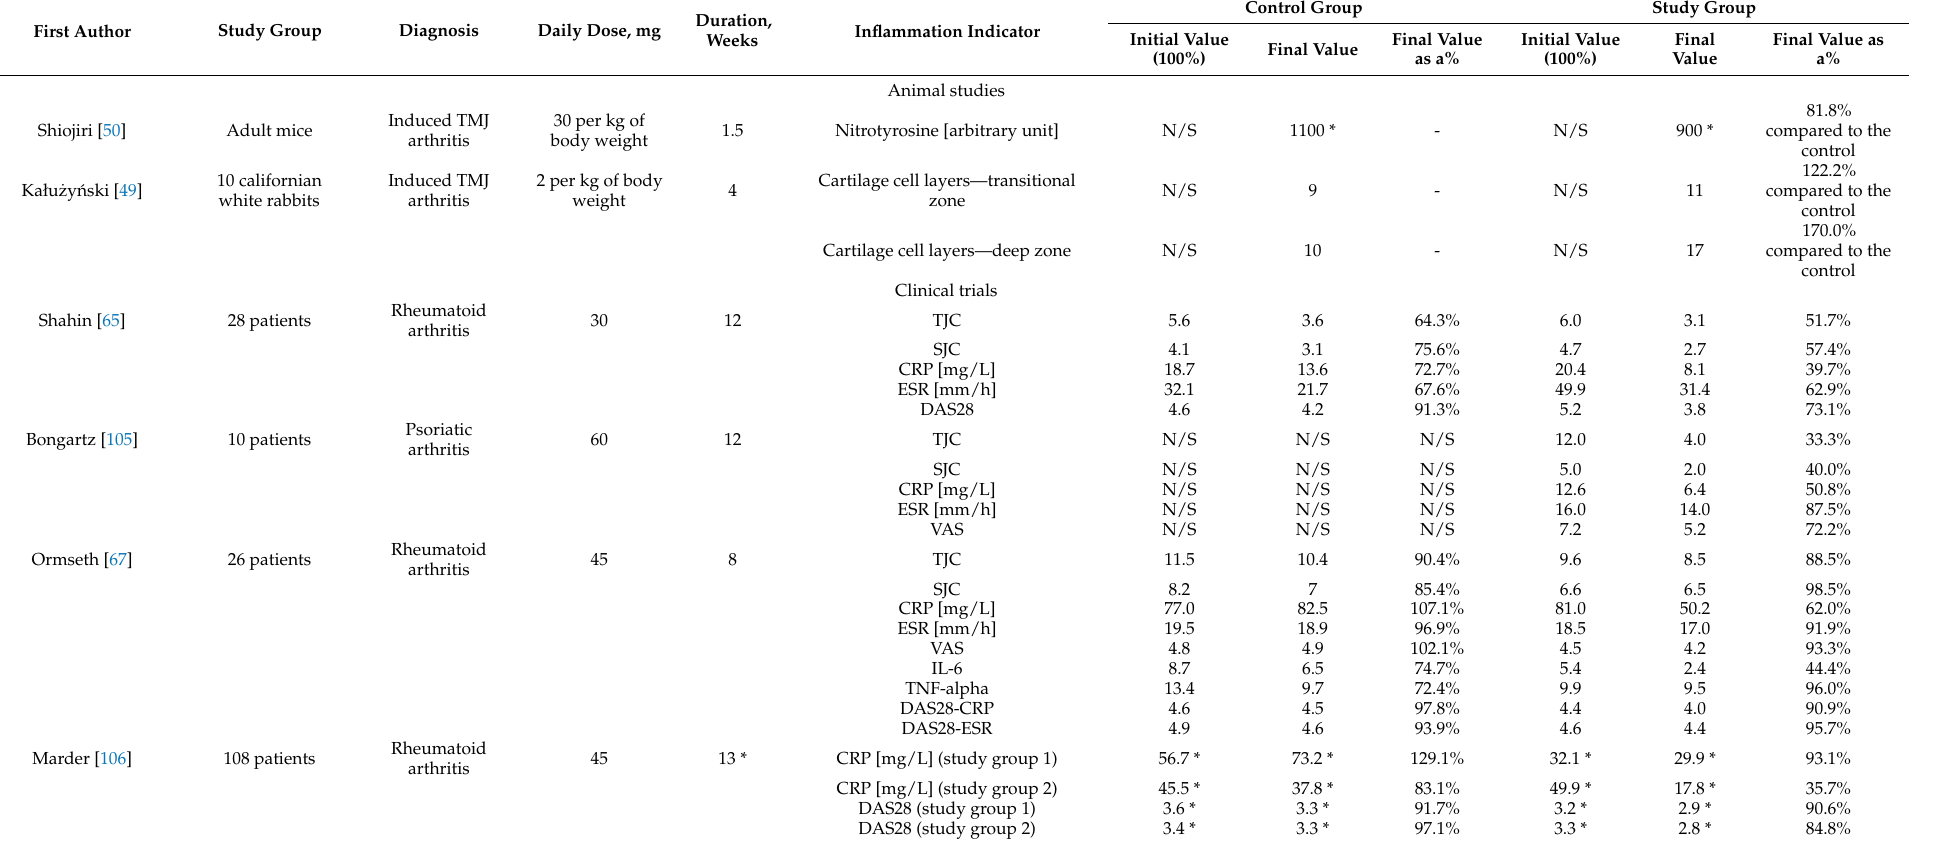
Table 2. Study characteristics and results of individual